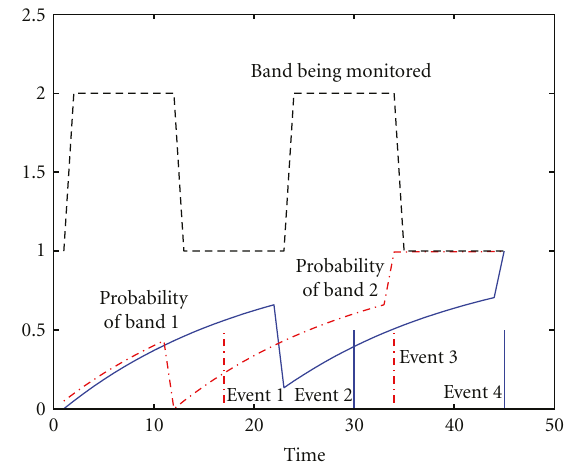
Figure 5: An example of control action